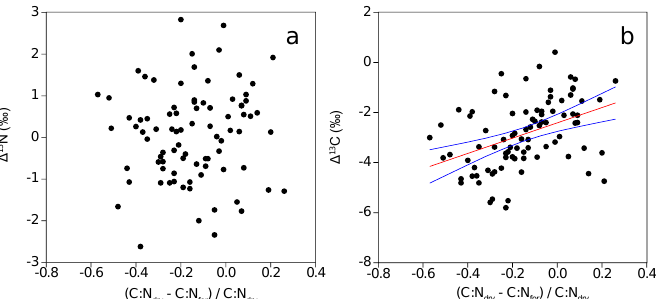
Figure 3. Relationships between the difference in ( a ) δ 15 N ( ∆ 15 N = δ 15 N for − δ 15 N dry ) or ( b ) δ 13 C ( ∆ 13 C = δ 13 C for − δ 13 C dry ) and the relative change in C:N ratio between formalin-preserved and dried zooplankton samples ([C:N dry − C:N for ]/C:N dry ). The significant ordinary least squares regression line for ∆ 13 C is indicated by red line and the corresponding 95% confidence limits in blue.